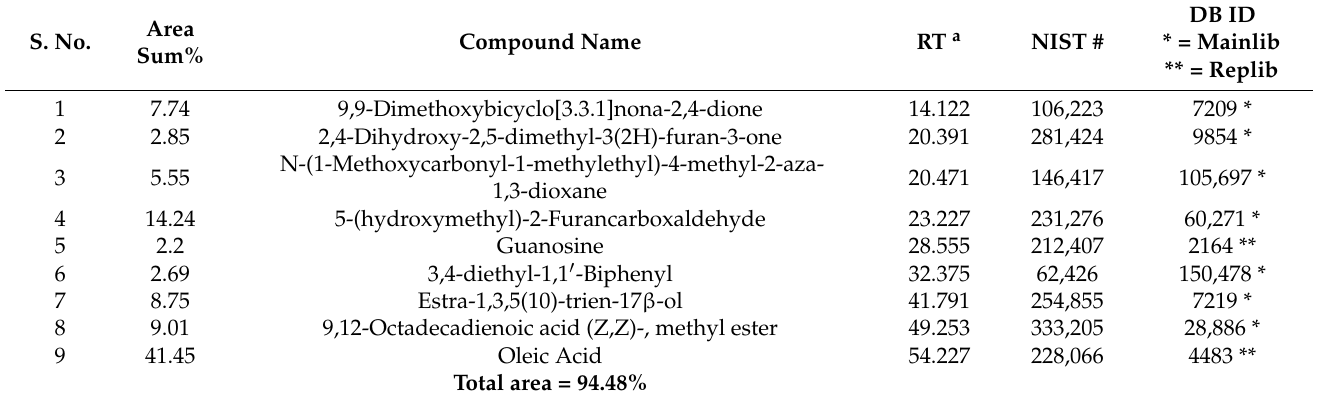
Table 2. GC and GC-MS analysis of A. absinthium essential oil